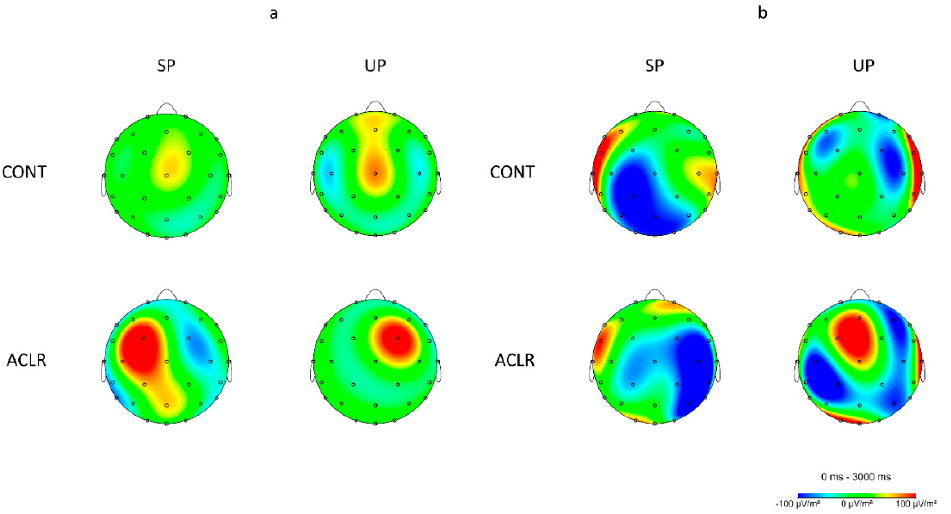
Figure 3. Mean topographical distribution ( top ) and plot ( bottom ) for significant main condition effects. The unstable condition significantly increased theta power in the centro-prefrontal ( a ), ipsilateral premotor ( b ), central primary motor ( c ), central and bilateral somatosensory ( d ), and primary visual cortices ( e ) and decreased alpha-2 power in the contralateral primary motor cortex ( f ), when compared to the stable condition (* p < 0.05).